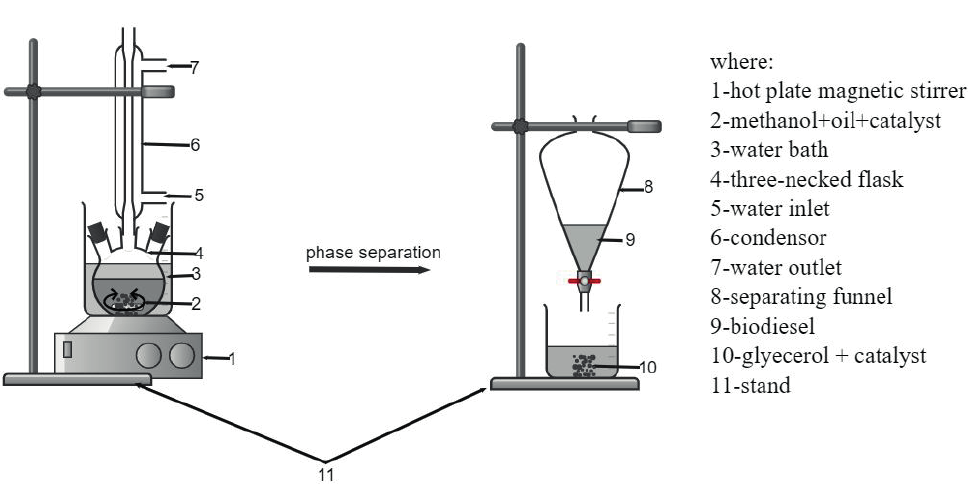
Fig. 2. Experimental set up for the transesterification process using a three-necked round bottomed